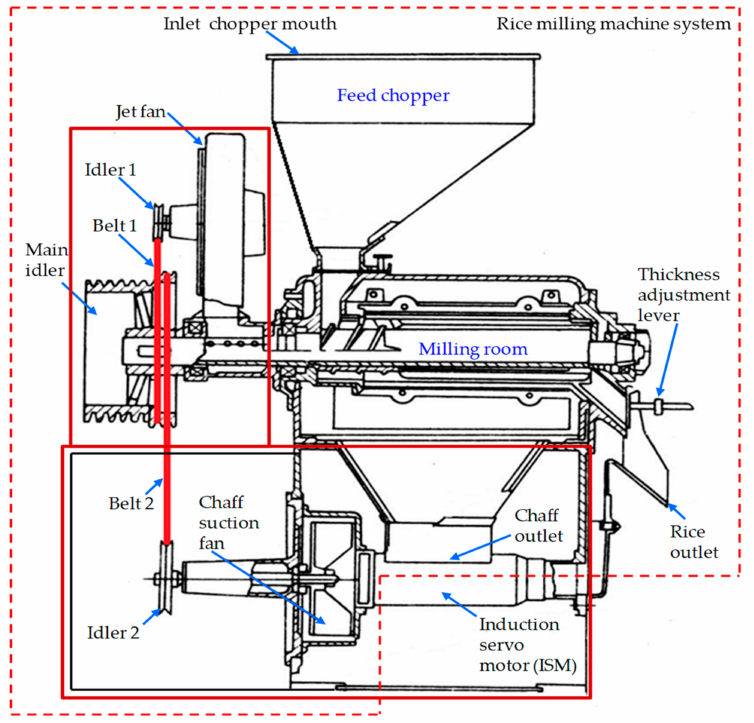
Figure 2. Adumbration view of the ISM and the rice milling machine